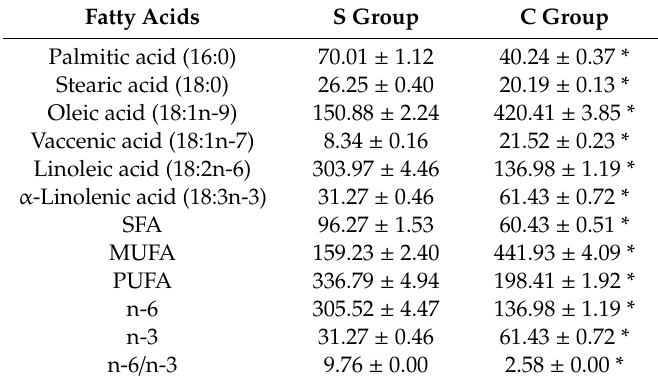
Results are expressed as mean ± standard error. Abbreviations: SFA, total saturated fatty acids; MUFA, total monounsaturated fatty acids; PUFA, total polyunsaturated fatty acids; n-6, omega-6 PUFAs; n-3, omega-3 PUFAs. p < 0.05 compared with S group *.